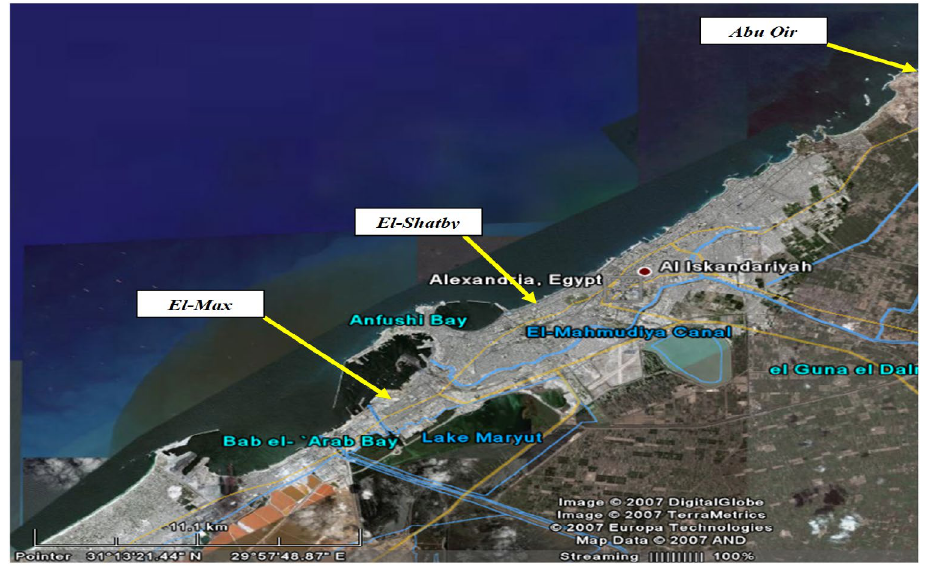
Fig. 1. Map of sampling area 20